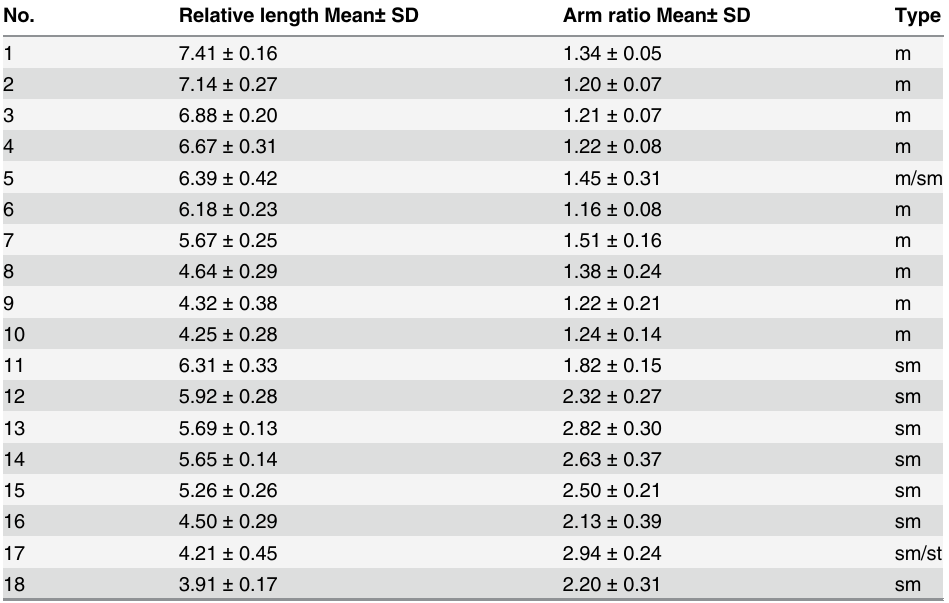
Table 1. Relative lengths and arm ratios of chromosomes of H. discus hannai .